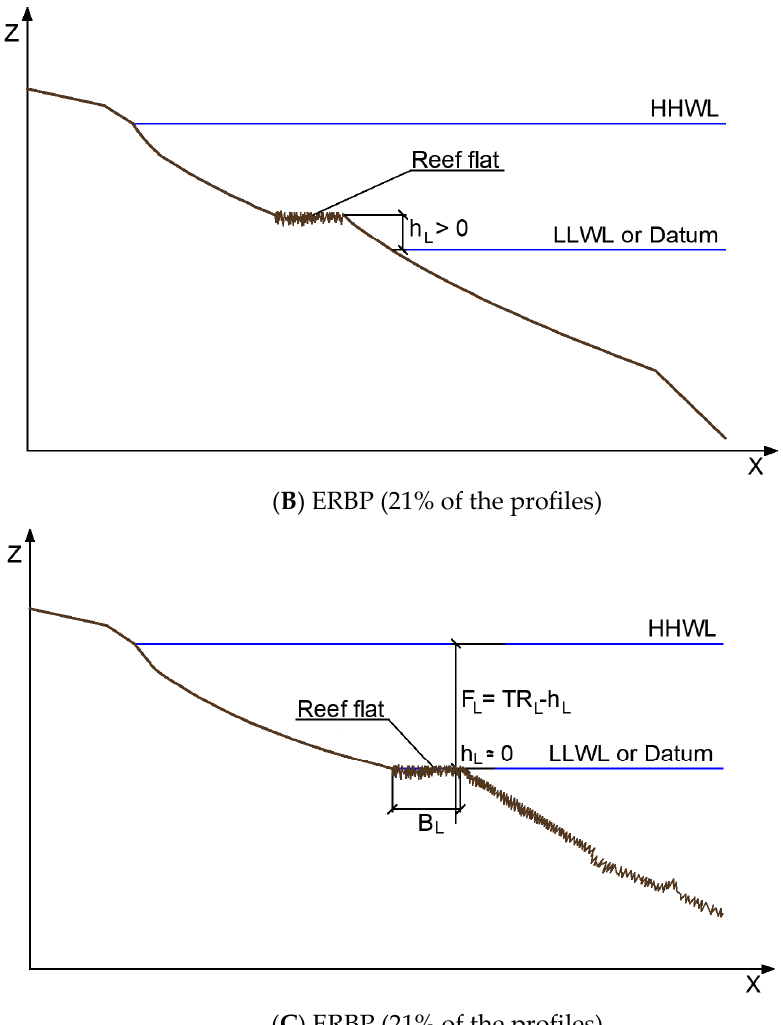
Figure 3. Definition of the three different types of profile supported on a reef flat in the SW coast of Spain: ( A ) Submerged Reef Bi-parabolic Profile (SRBP), ( B ) Emerged Reef Bi-parabolic Profiles (ERBP), and ( C ) Reef Mono-parabolic Profile (RMP).